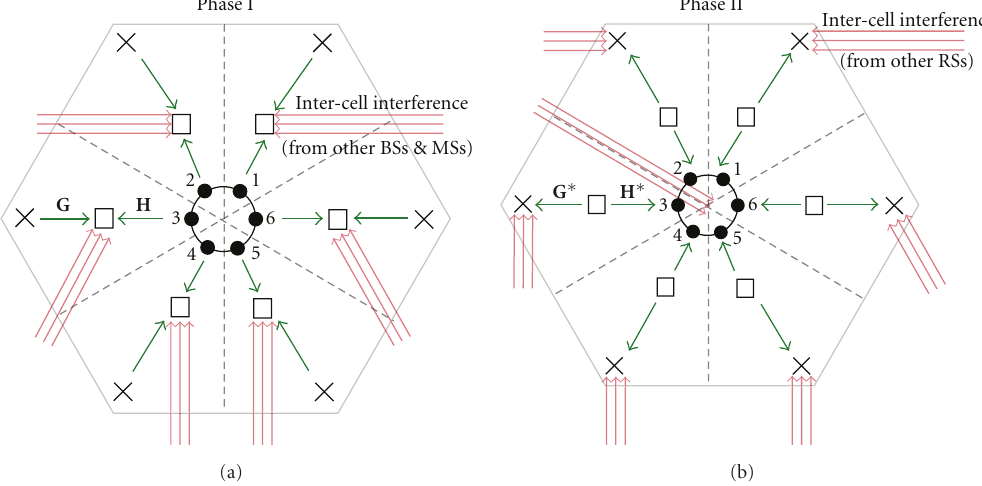
Figure 4: Two-way relaying operation in a single cell. In the first phase, all transceivers transmit except the relays. In the second phase, only relays transmit, and other transceivers are able to cancel the interference they caused in the first